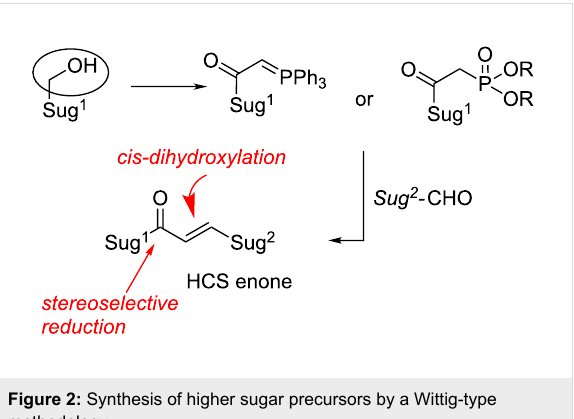
Figure 2: Synthesis of higher sugar precursors by a Wittig-type